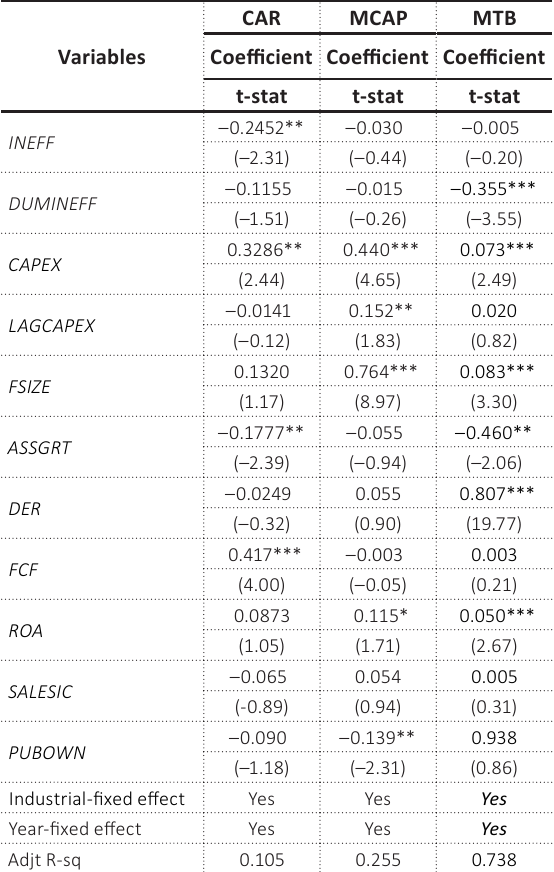
Table 6. Market response to inefficient investment